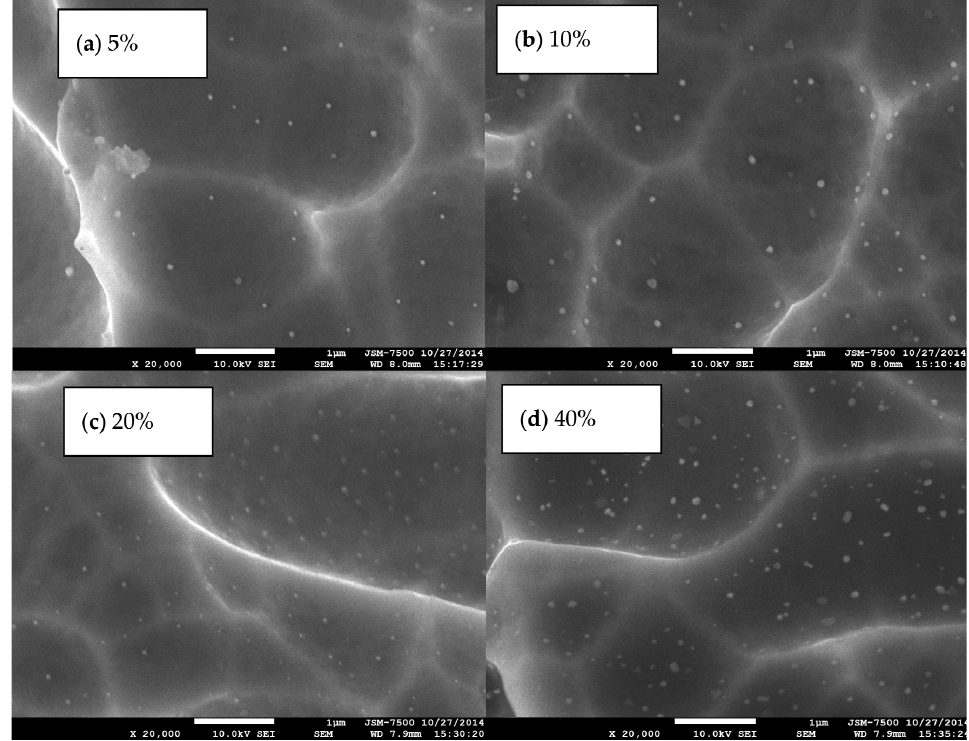
Figure 2. The surface field ‐ emission scanning electron microscope (FESEM) images of Au nanoparticles at a concentration of ( a ) 5%; ( b ) 10%; ( c ) 20% and ( d ) 40% on mc ‐ Si solar cells.